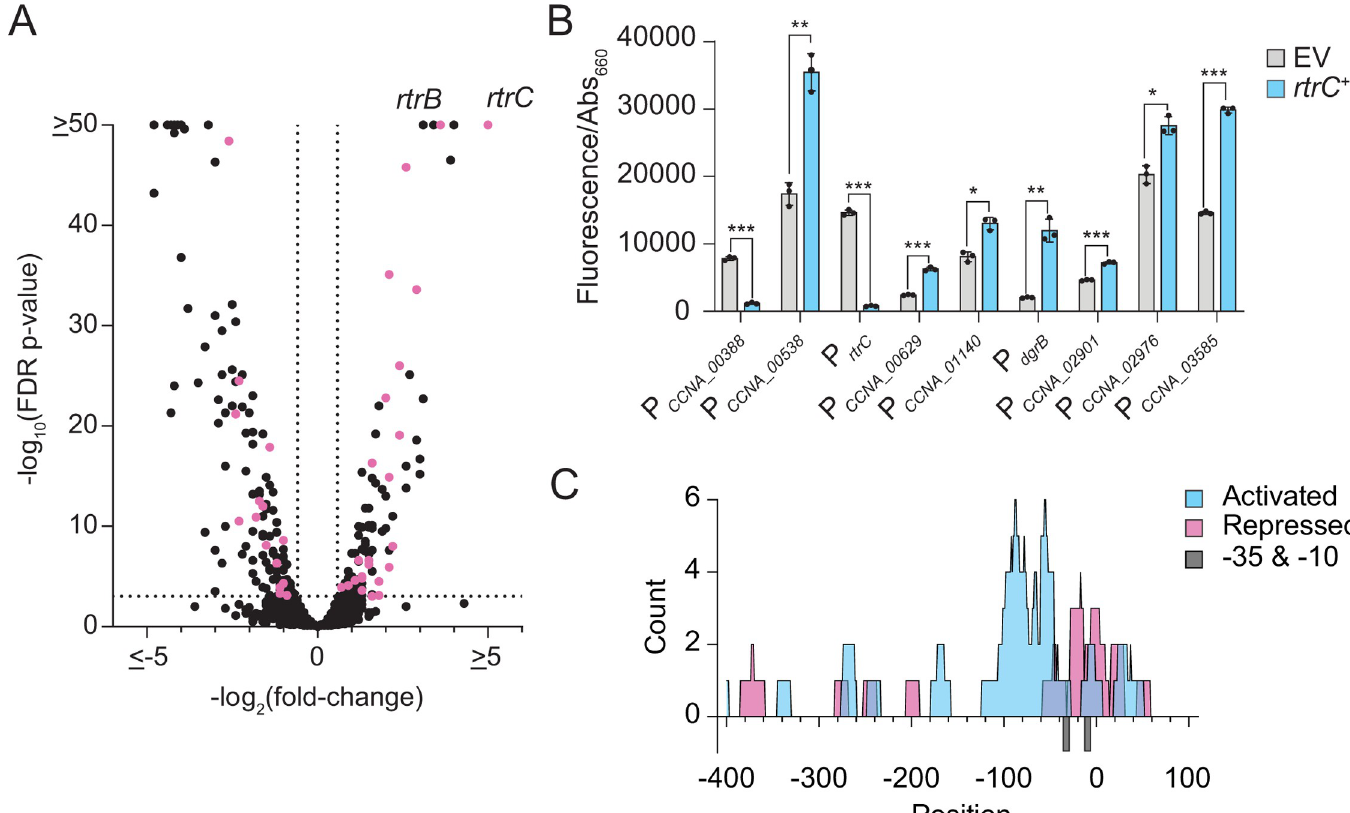
Fig 5. RtrC functions as a transcriptional activator and repressor. A) RNA-seq analysis of genes significantly regulated upon rtrC overexpression. Volcano plot showing log 2 (fold-change) in transcript levels in an rtrC overexpression strain ( rtrC ++ ) versus empty vector (EV) are plotted against -log 10 (FDR p-value). Black dots indicate genes without RtrC motifs and pink dots indicate genes with RtrC motifs in their promoters. Data calculated from four biological replicates. B) Transcription from predicted RtrC-regulated promoters measured by promoter fusions to mNeonGreen . Cells grown in complex medium (PYE) and fluorescence measured in rtrC ++ or empty vector (EV) backgrounds was normalized to cell density (OD 660 ). Data show the mean signal; error bars are standard deviation of three biological replicates. Statistical significance was determined by multiple unpaired t tests, correcting for multiple comparisons using the Holm-Sˇı´da´k method (p-value � 0.05, � ; p-value � 0.01, �� ; p-value � 0.001, ��� ). C) Activity of RtrC as a transcriptional activator or repressor correlates with position of the pseudo-palindromic RtrC motif in the promoter. Distribution of RtrC motifs in promoters (-400 to +100 bp from the transcription start site; TSS) directly regulated by RtrC. Position of RtrC motifs relative to the TSS in each promoter were plotted. Blue indicates motif positions in promoters activated by RtrC (n = 26) and pink indicates motif positions in promoters repressed by RtrC (n = 16). Grey bars below the x-axis indicate the -35 and -10 positions relative to the annotated